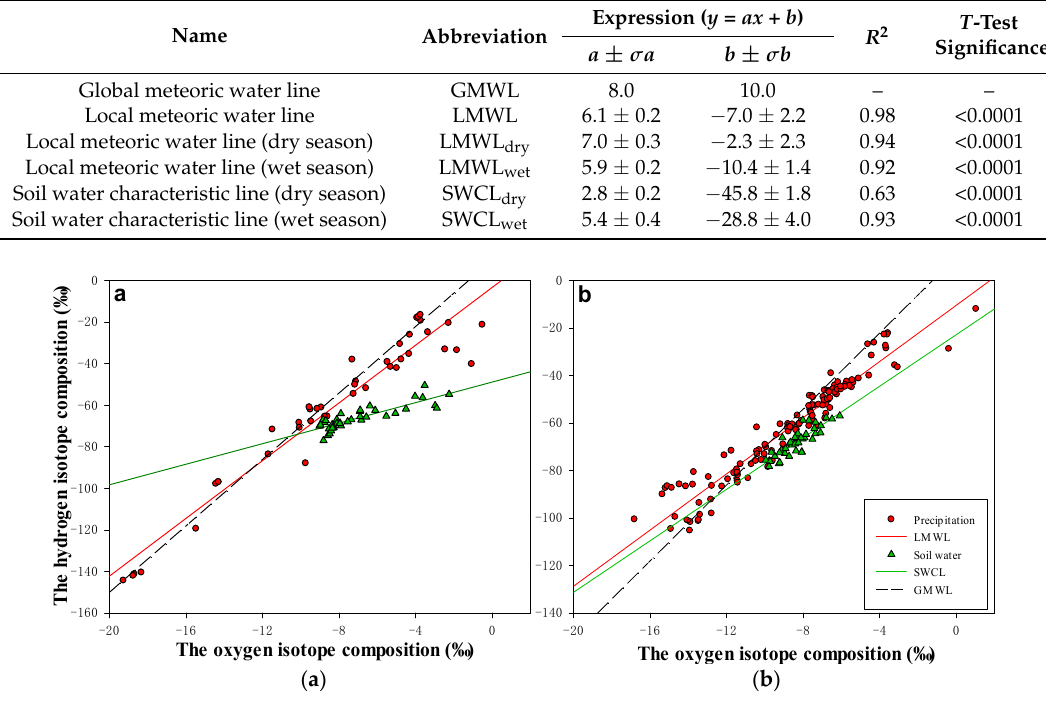
Figure 3. The relationship between isotopic ratios in precipitation and soil water. ( a ) the relationship between isotopic ratios in precipitation and soil water in dry season ( b ) The relationship between isotopic ratios in precipitation and soil water in wet season. The LMWL was δ 2 H = 7.0 δ 18 O − 2.3 ( R 2 = 0.94, N = 42) and δ 2 H = 5.9 δ 18 O − 10.4 ( R 2 = 0.92, N = 126) for the precipitation in the dry and wet seasons, respectively. The SWCL was δ 2 H = 2.8 δ 18 O − 45.8 ( R 2 = 0.63, N = 80) and δ 2 H = 5.4 δ 18 O − 28.8 ( R 2 = 0.93, N = 100) for the soil water in the dry and wet seasons, respectively. The GMWL was δ 2 H = 8 δ 18 O + 10 [37].